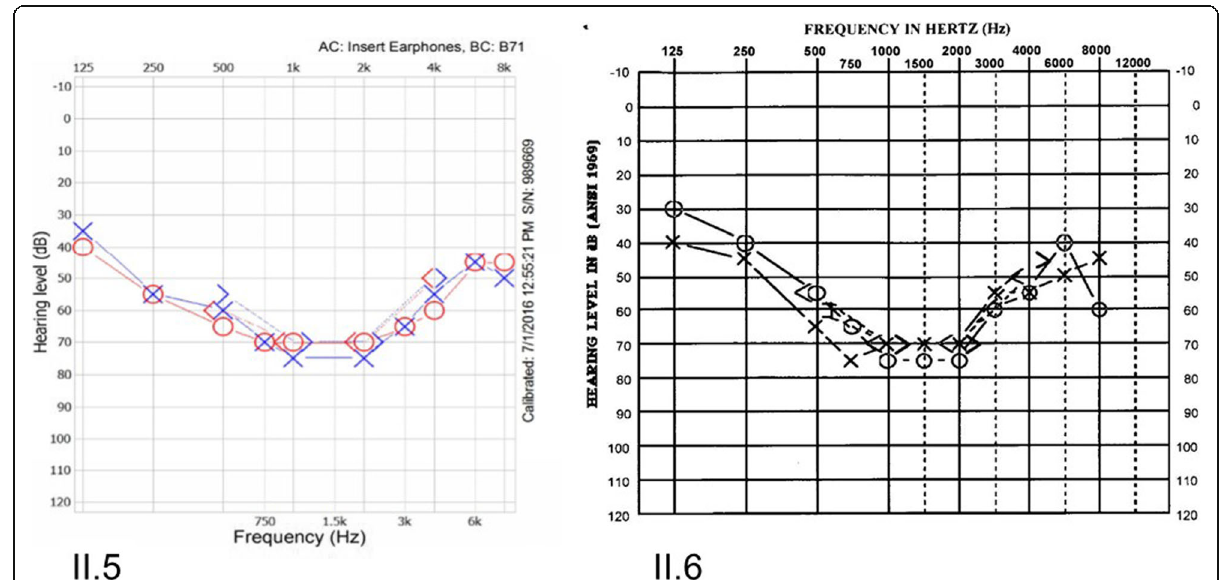
Fig. 2 Audiograms of the affected probands. The audiograms show mild to severe progressive hearing loss in both ears for both affected individuals (II.5) and (II.6). The audiograms were taken at the time of